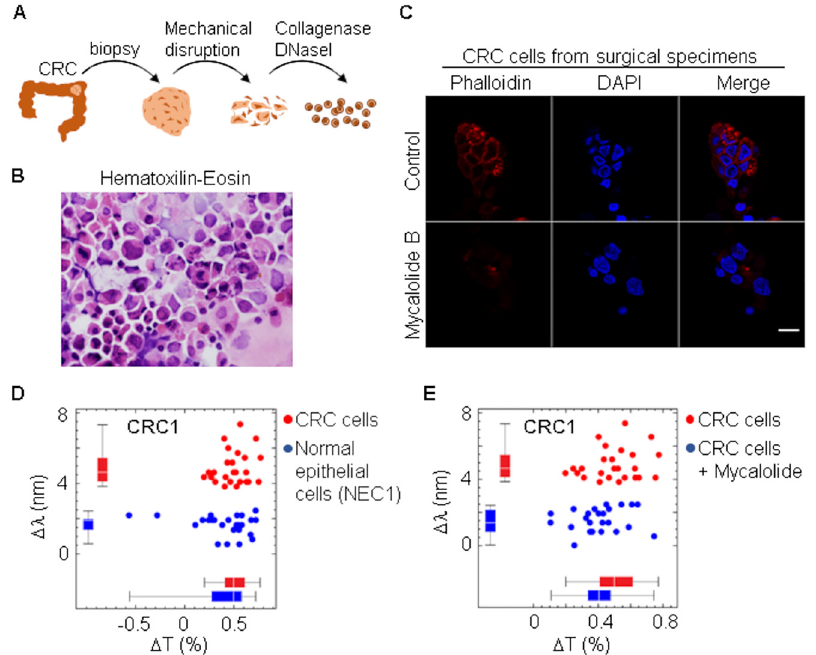
Figure 11: Experimental setup to study the spectral behaviour of primary cancer cells. (A) Scheme of the procedure used to obtain a population of individual cells from colorectal cancer (CRC) tissue obtained from surgical specimens. Non-necrotic tissue was washed with saline buffer and mechanically disaggregated into very small pieces. Disaggregated tissue was incubated with 250 mg/mL collagenase I and 150 mg/mL DNase I for 1 h at 37 ° C and then fi ltered through 40 μ m cell strainer to obtain individual cells. (B) Representative cytospin preparation of isolated cells after hematoxylin-eosin staining. (C) Isolated cells were fi xed with 4% paraformaldehyde for immuno fl uorescence staining of actin cortex (phalloidin). DAPI was used to label nuclei. Scale bar: 20 μ m. (D) Spectral shift and change in transmittance comparing isolated CRC cells and normal epithelial cells (NEC) obtained from the same surgical piece.(E)SpectralshiftandchangeintransmittancecomparingisolatedCRCcellswithoutandwithprevioustreatmentwith5 μ MmycalolideB. Threshold was set to 3.0 nm, which determined sensitivity and speci fi city 100% in both (D) and (E)